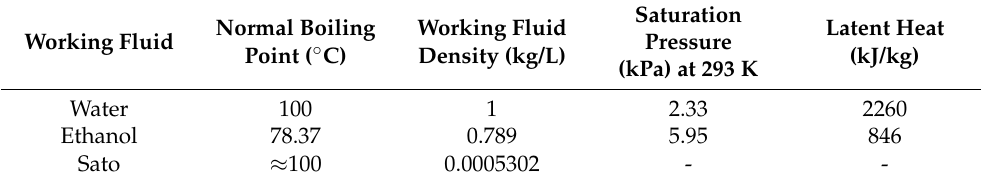
Table 1. Physical properties of the raw